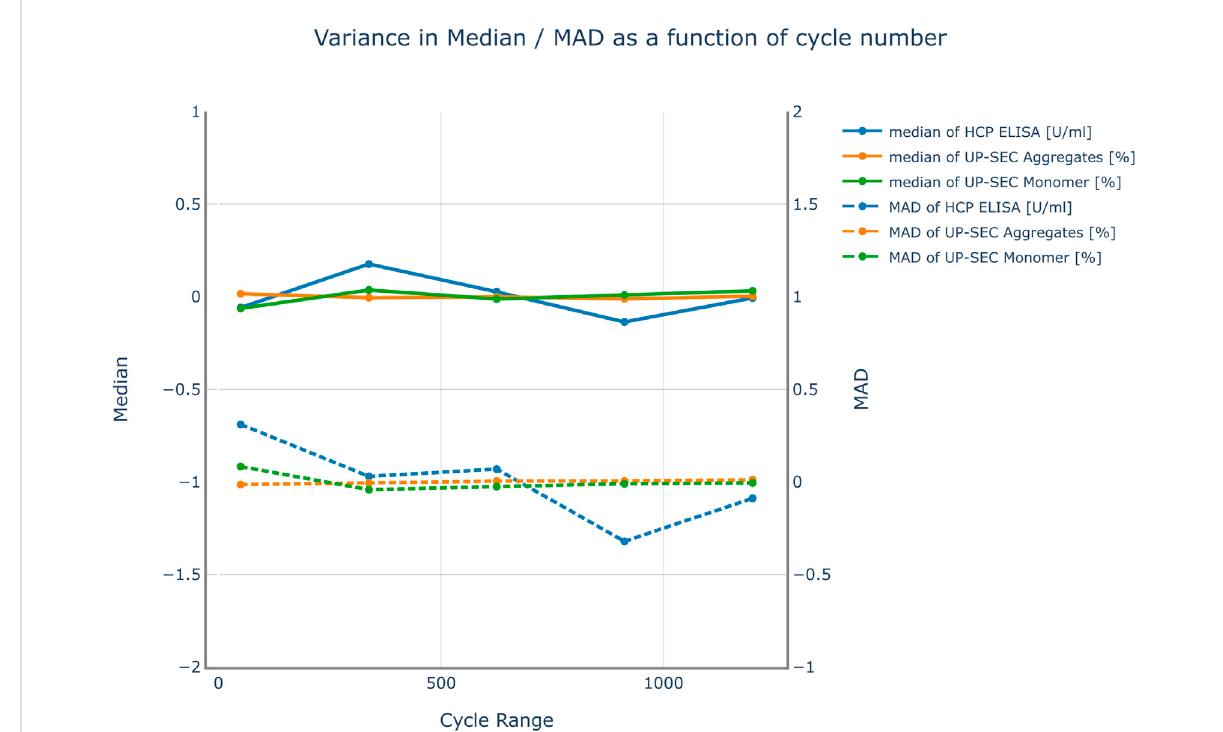
FIGURE 3 Variance of the median response and the mean absolute deviation (MAD) over the number of cycles used in the Monte Carlo simulation for all responses. The results were mean centered for visualization purposes. No severe changes in variance of the median prediction and the prediction variance were observed. Therefore, it was not expected that an increase in the number of simulation cycles improves the accuracy of the model